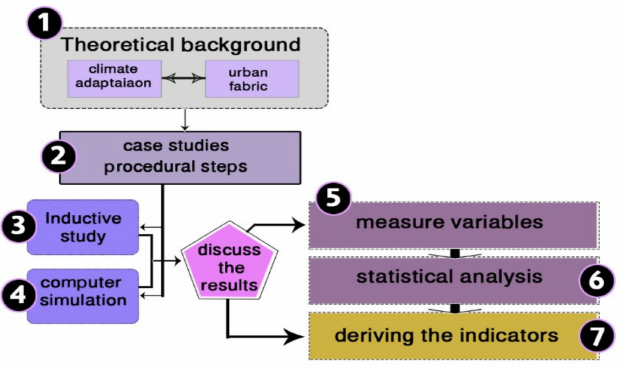
Figure 1. Methodology